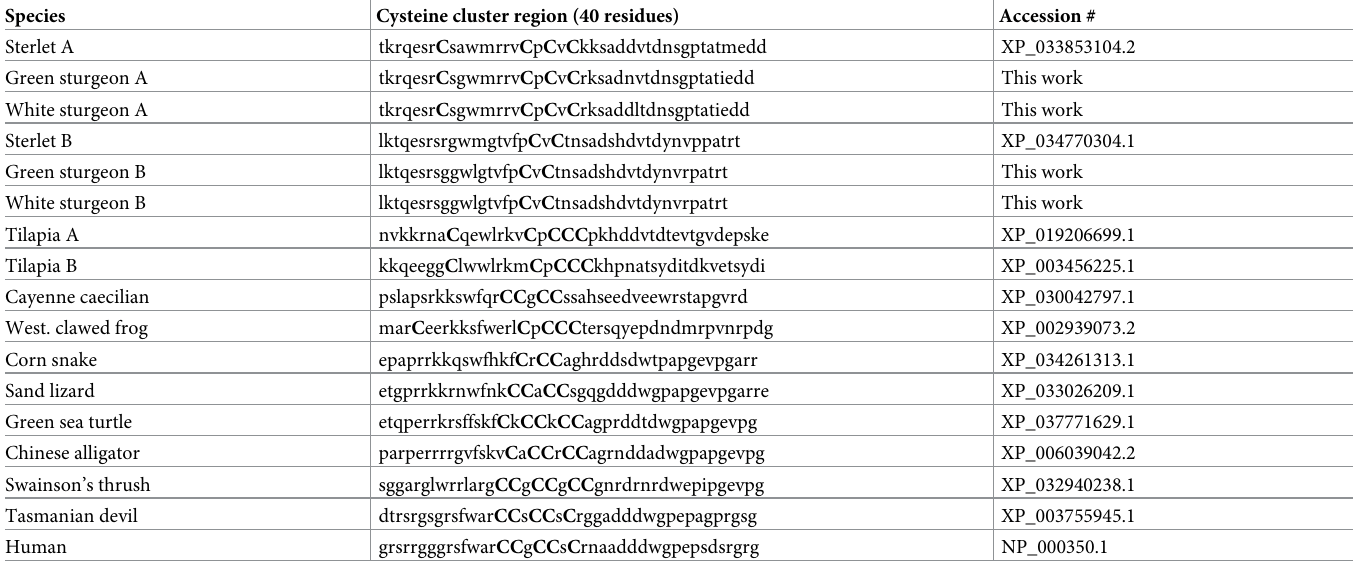
Segments of 40 residues are given centered on the cysteine cluster. Cysteine residues are capitalized and in